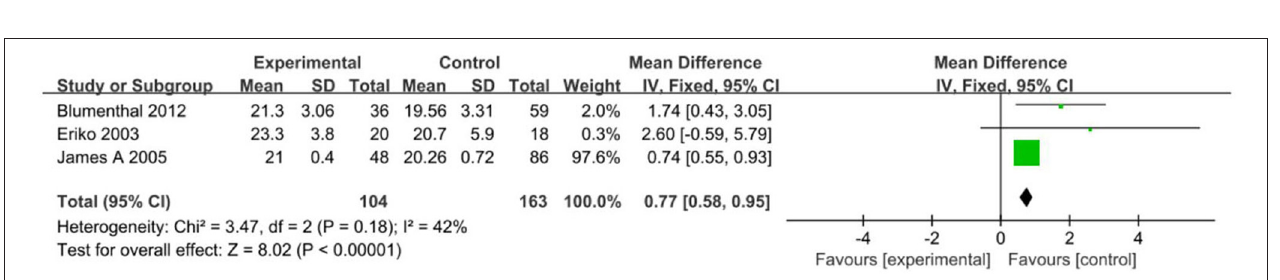
Frontiers in Cardiovascular Medicine |